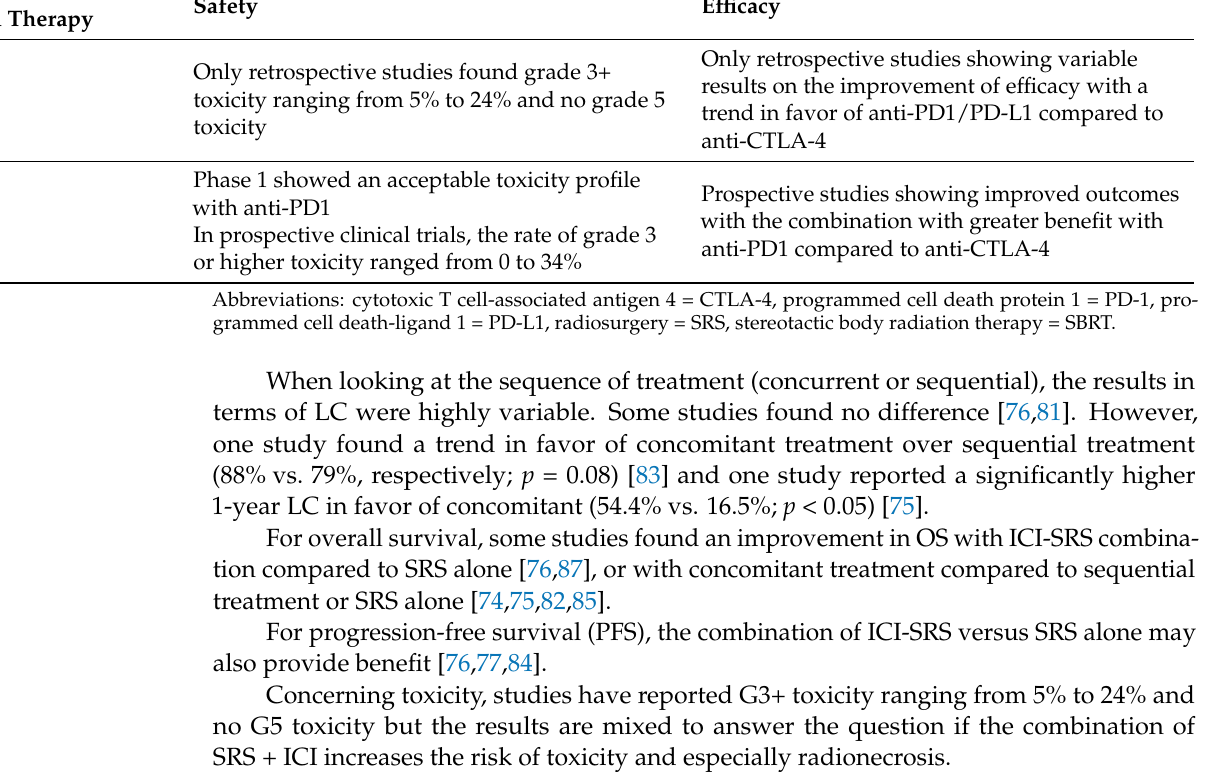
Table 2. Level of evidence for safety and efficacy of the combination immune checkpoint inhibitor (anti-CTLA-4 and anti-PD1/PDL-1) and stereotactic radiation therapy. Type of Stereotactic Safety Efficacy Radiation Therapy Only retrospective studies found grade 3+ SRS toxicity SBRT